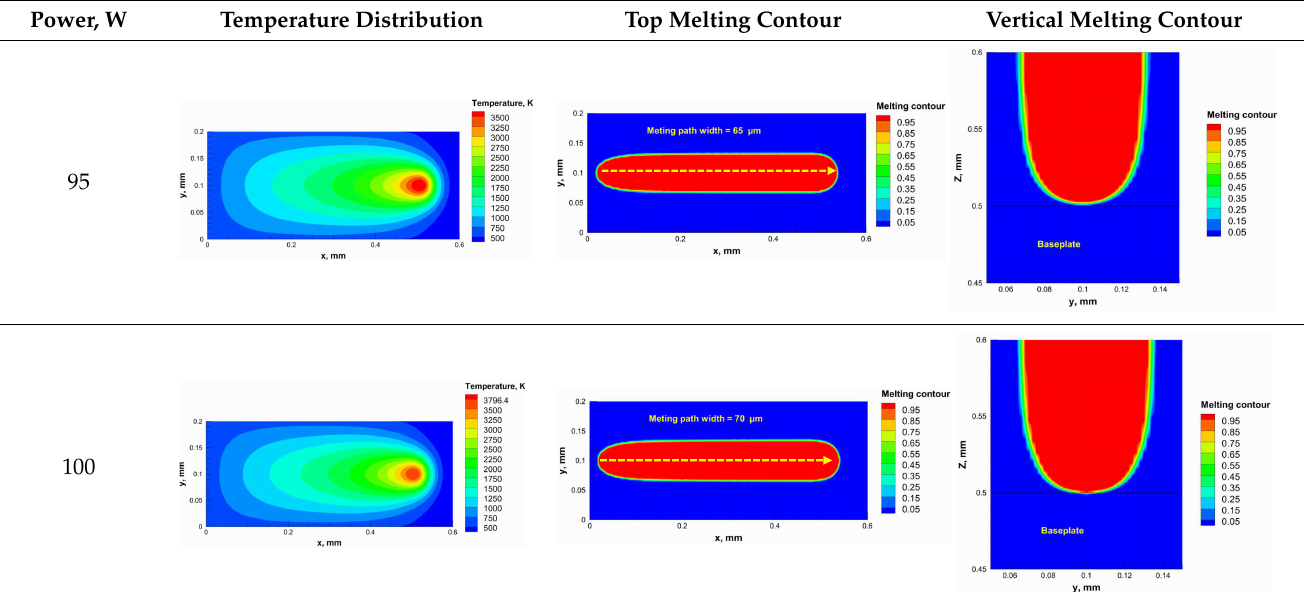
Table 5. Temperature distribution and melting contour obtained from the numerical model (Nd-YAG).